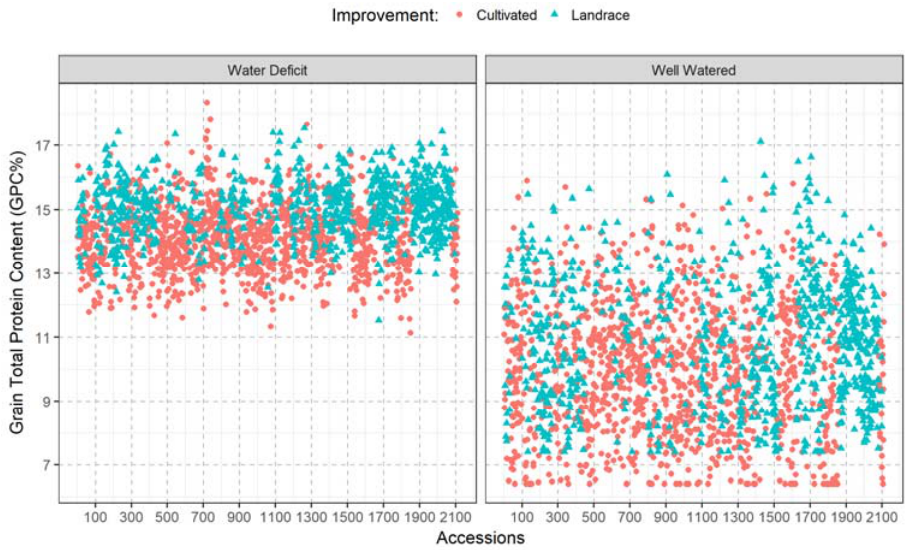
Figure 1. Boxplot for the overall performance of the 2111 wheat accessions across the four environments (well ‐ watered and water ‐ deficit conditions in 2016 and 2017 growing seasons).